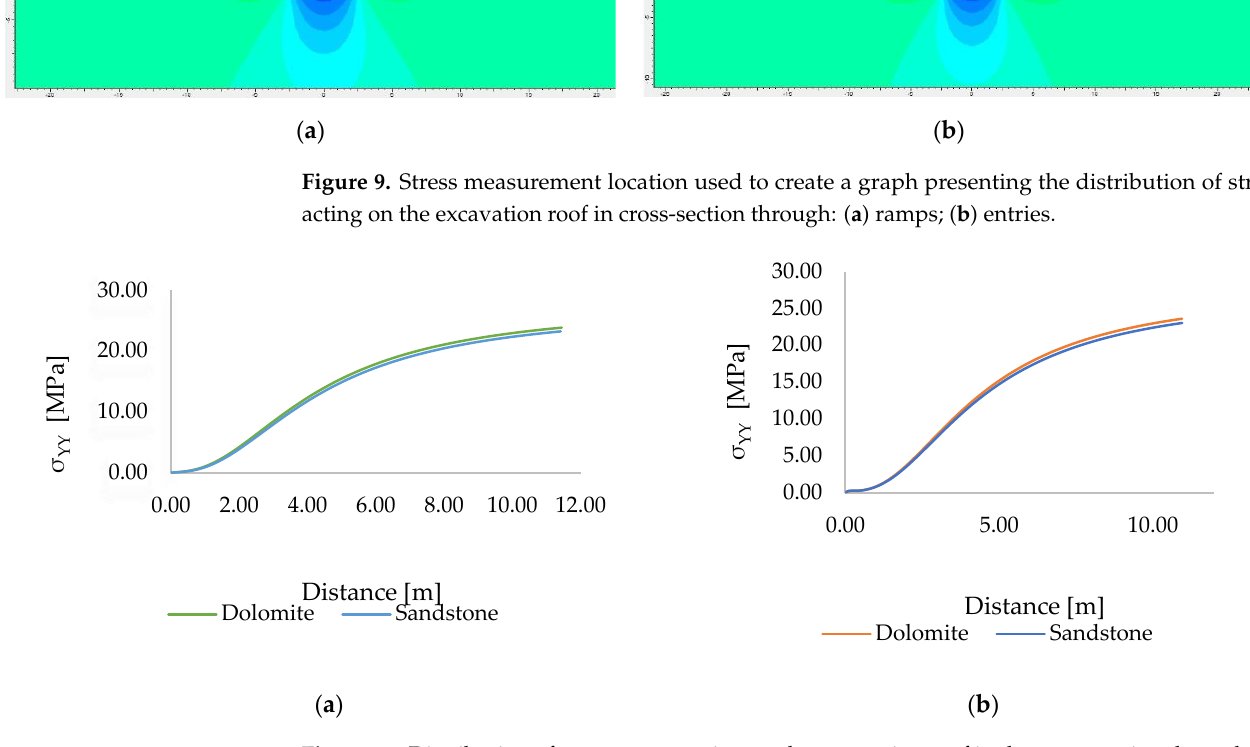
Figure 11. Stress measurement location used to create a graph presenting the distribution of stress acting on protective pillars in the cross-section through: ( a ) ramps; ( b ) entries.